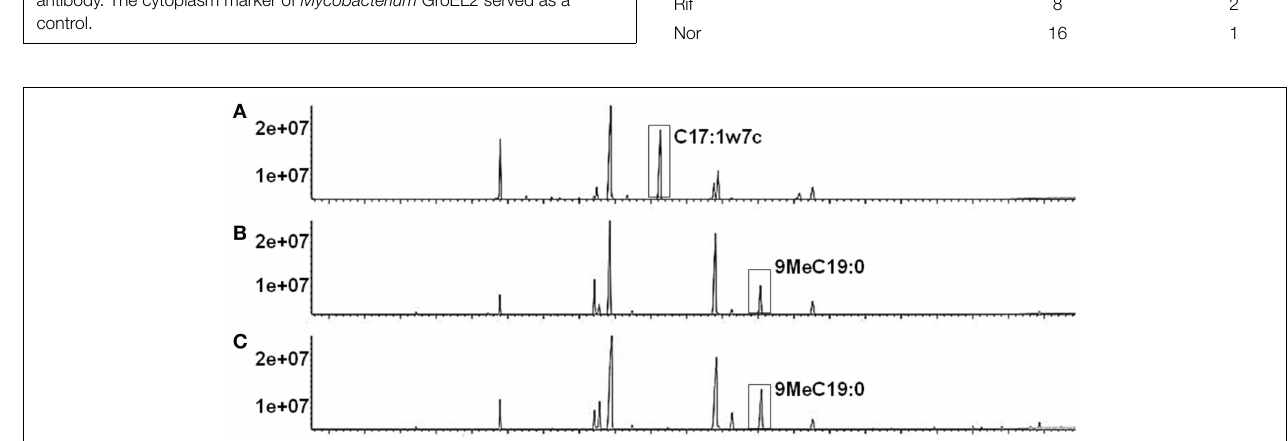
FIGURE 3 | The fatty acid component in cell wall of recombinant Ms_Rv1169c (A), Ms_Vec (B), and wild-type M. smegmatis (C) .